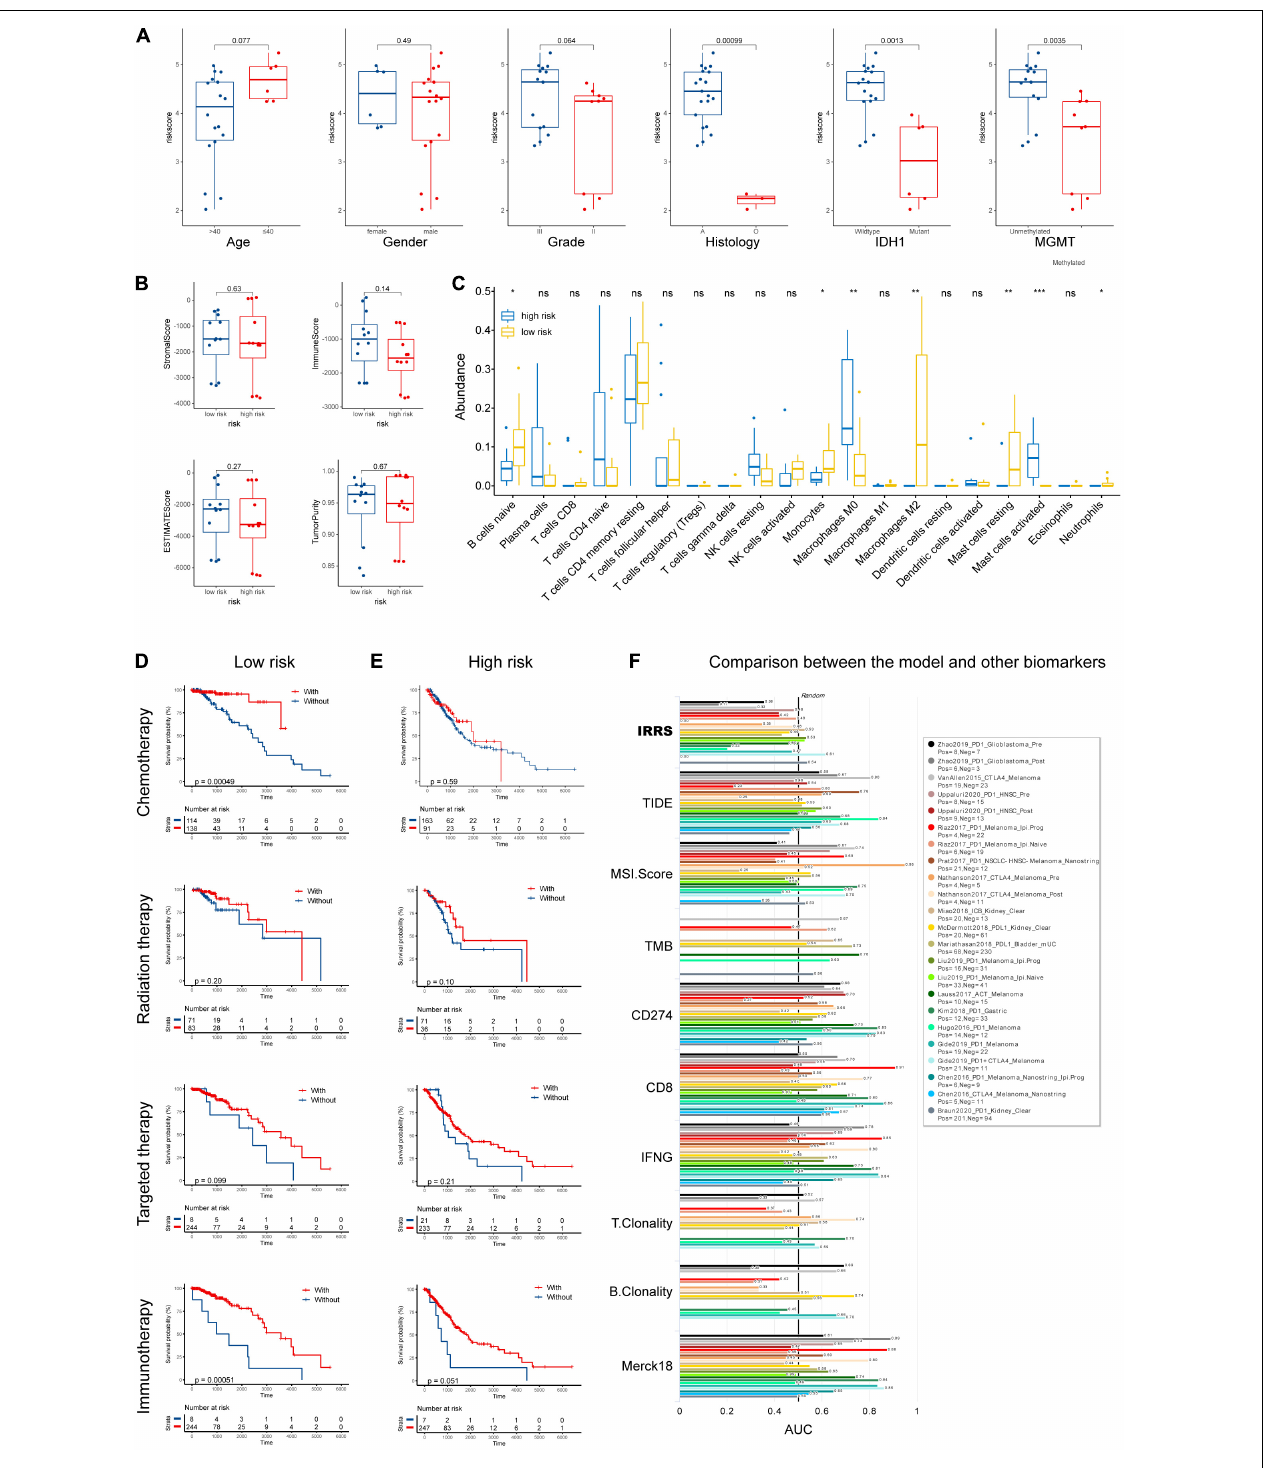
FIGURE 5 | Validation using collected samples and prediction of therapy efficacy. (A) The risk score in different subgroups stratified by age, gender, grade, histological type, IDH1 status, and MGMT status using own samples. (B) Stromal, immune, and ESTIMATE scores compared between high- and low-risk groups. (C) The abundances of various immune cells in the high- and low-risk groups. (D,E) The efficacies of chemotherapy, radiation therapy, targeted therapy, and immunotherapy in the low- and high-risk groups. (F) Comparison of the abilities in predicting the response to immunotherapy with recognized biomarkers or genes. * p < 0.05, ** p < 0.01, *** p < 0.001, ns: not significant.